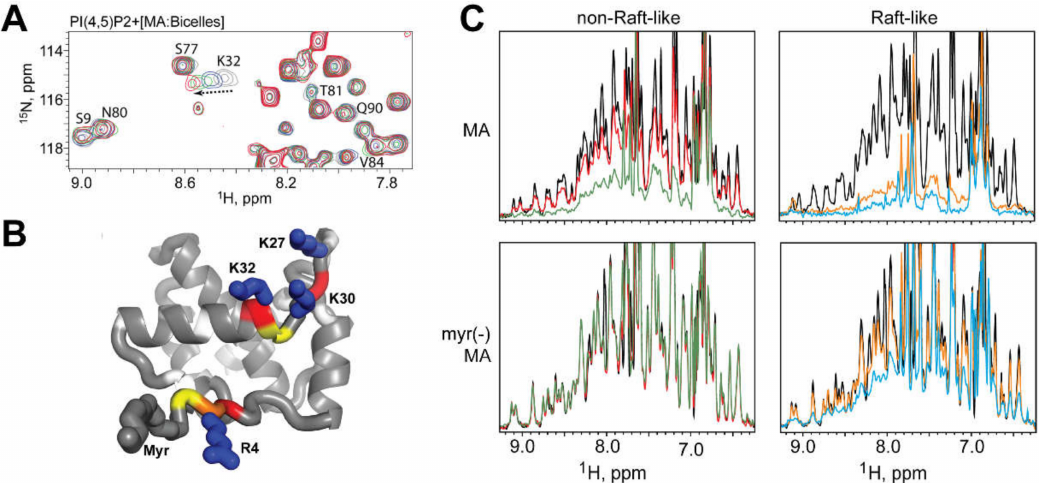
Figure 3. NMR studies of HIV-1 MA structure and membrane targeting. ( A ) 1 H- 15 N HSQC spectra of 15 N-labeled MA titrated into bicelles containing increasing mol% native PI(4,5)P 2 , reveal the binding mode of MA to plasma membrane mimetics. ( B ) Solution structure of MA determined by NMR. Residues showing large chemical shift perturbations in ( A ) are highlighted. ( C ) 1 H NMR spectra of MA and myr(-) MA upon addition of liposomes with varying phospholipid compositions. Signal loss indicates binding. MA can bind non-Raft-like membranes due to myristoyl group interactions. Binding to Raft-like membranes is significantly enhanced. Adapted from [127] with